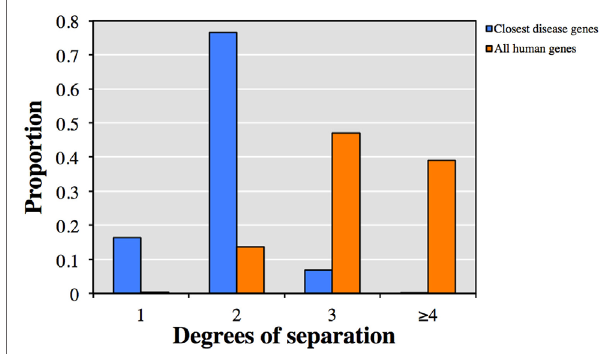
FIGURe 1 | Predicted degrees of separation between (blue) the 13,005 genes from human gene mutation database (HGMD) not known to be disease-causing and their closest predicted HGMD disease-causing genes, and (orange) between all pairs of human genes.